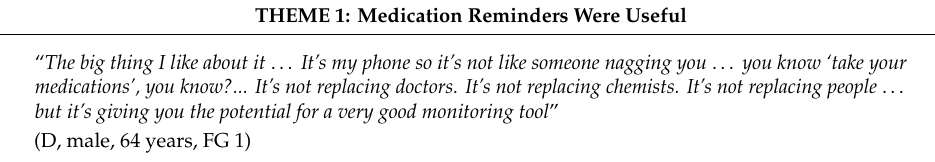
Table 5. Quotes highlighting themes that were identified in the focus